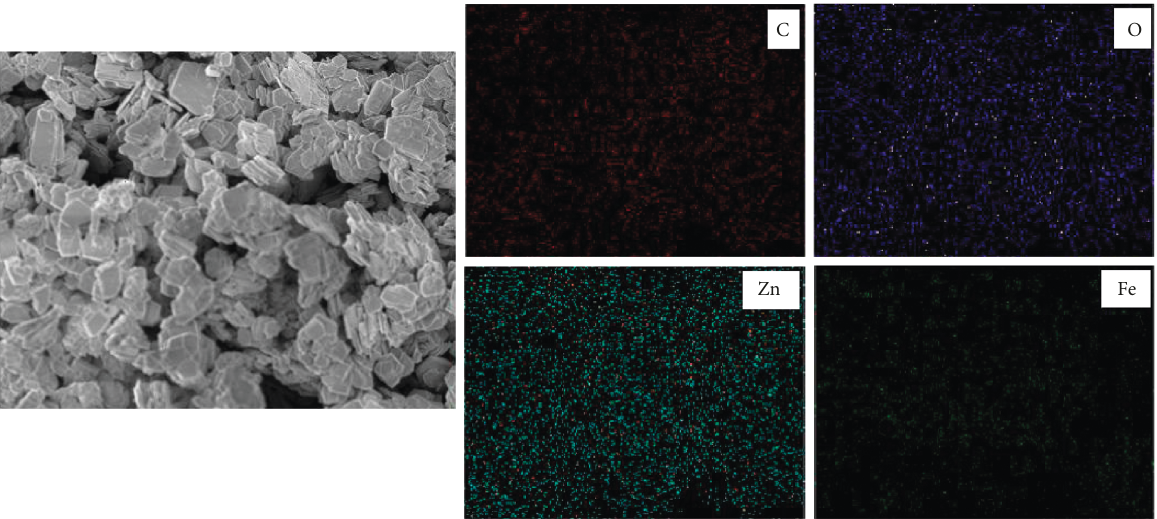
Figure 5: Element mapping of Fe(II)/MOF-5 (3% Fe 2+ ).